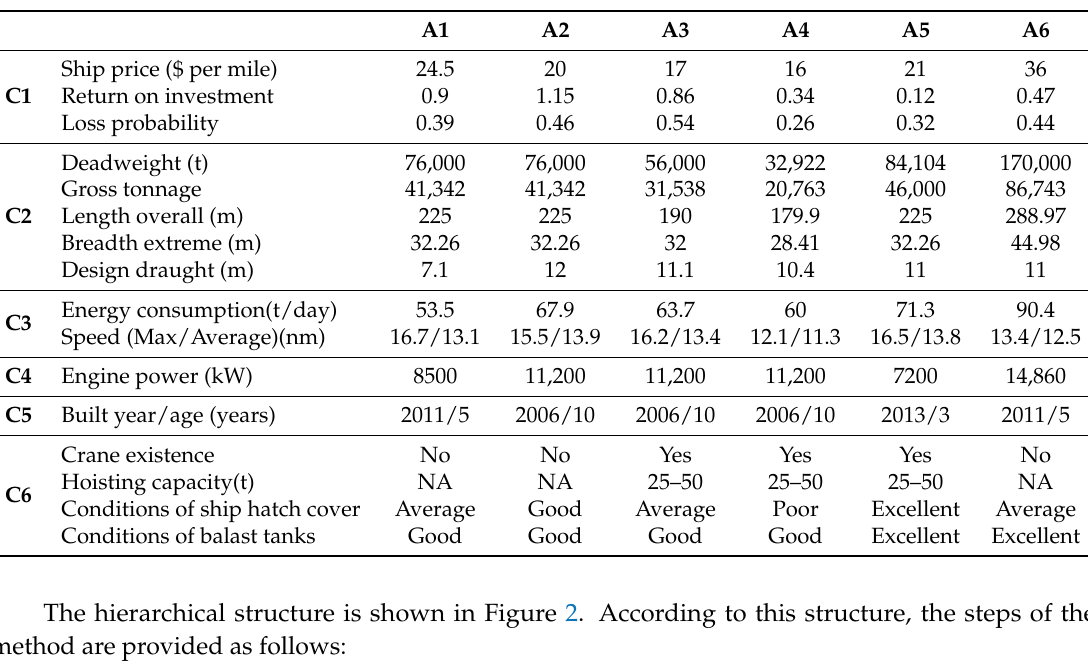
Table 4. Values of the alternatives based on given criteria.